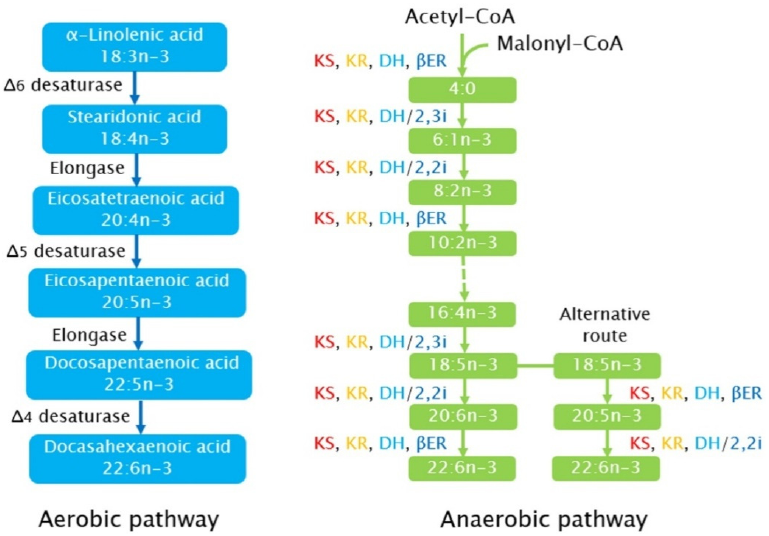
Figure 1. A schematic illustration of the aerobic and anaerobic pathways assumed for microalgae. For the anaerobic pathway, enzymes involved are the 3-ketoacyl synthase (KS—red), 3-ketoacyl reductase (KR—orange), dehydrase/isomerases (DH—light blue), DH/2,2i = dehydrase 2- trans , 2- cis isomerase, DH/2,3i = dehydrase 2- trans , 3- cis isomerase, and enoyl reductase ( β ER—blue). (Modified from figures in [1,10,78].